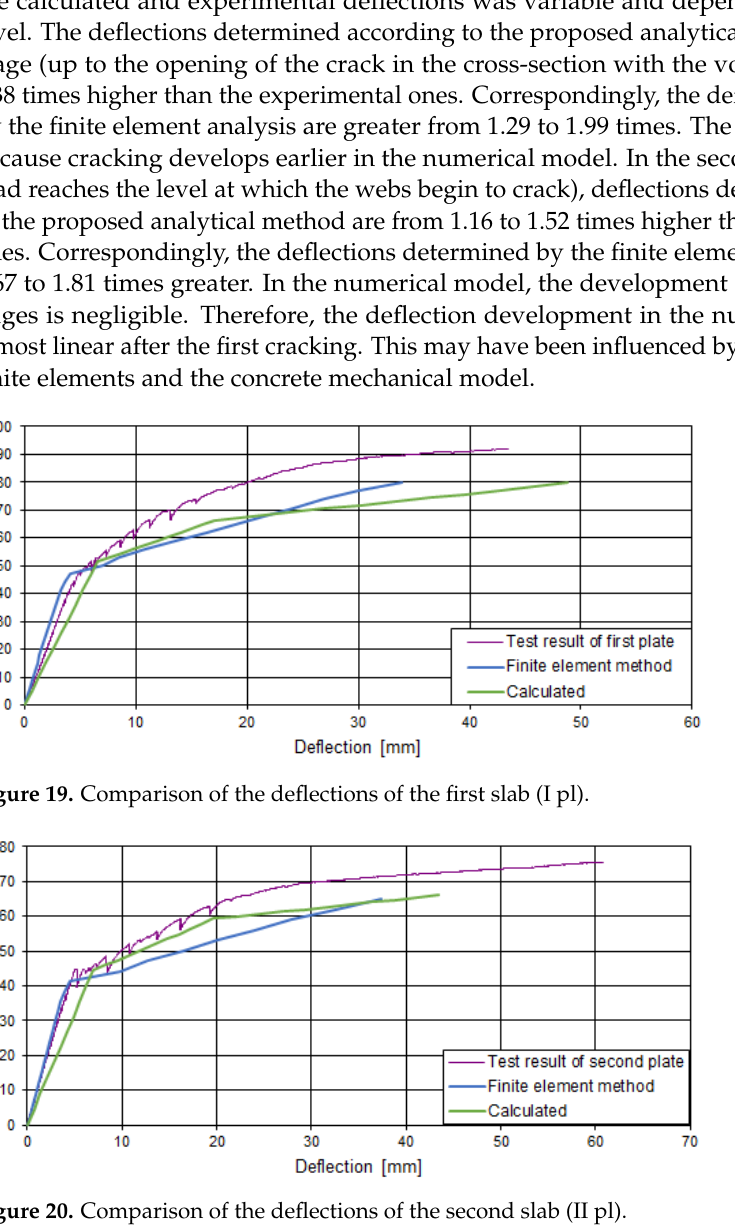
Figure 20. Comparison of the deflections of the second slab (II pl). Relationships between bending moments and strains of prestressed concrete